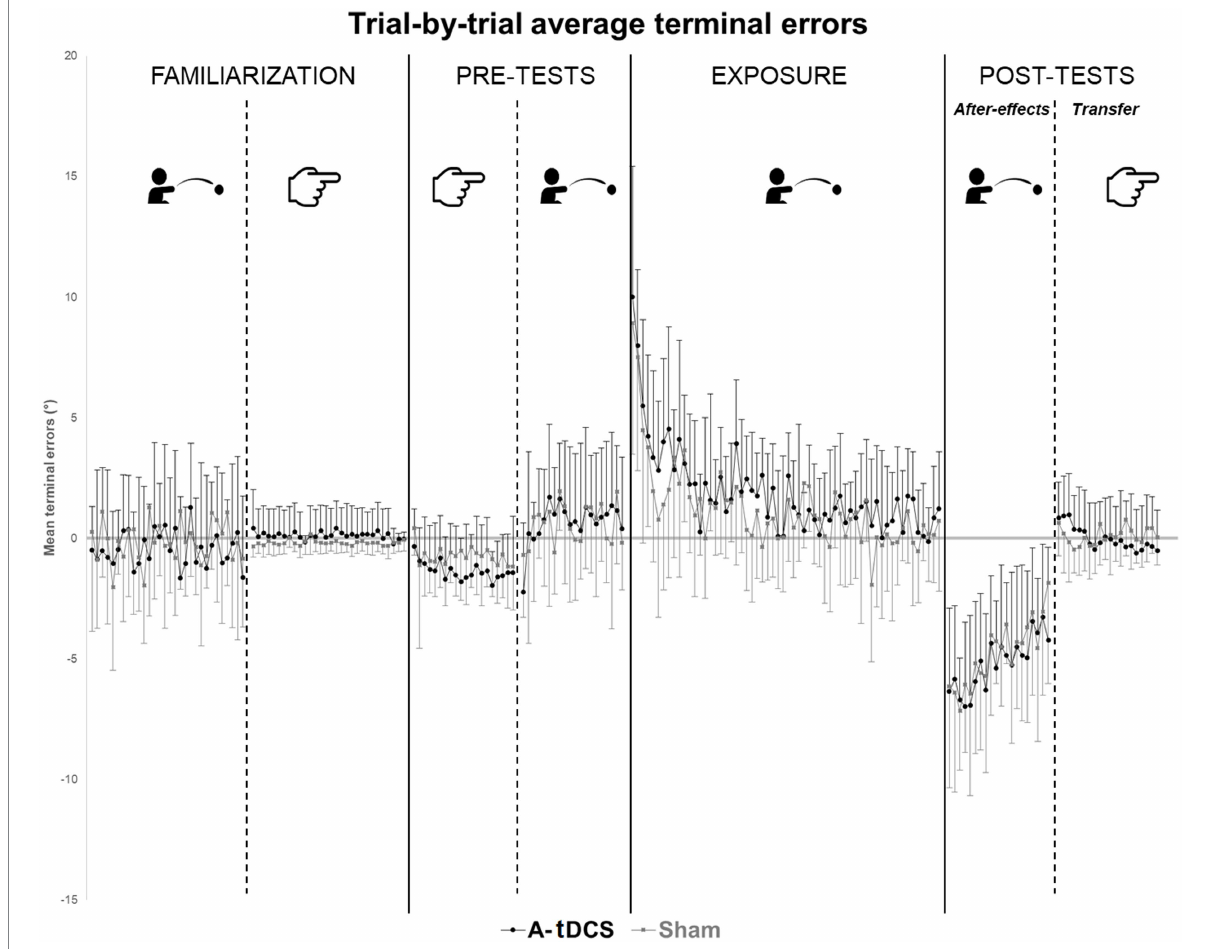
FIGURE 2 Trial-by-trial average terminal errors. Trial-by-trial average group terminal errors are represented with standard deviations for each group (A-tDCS group in black, Sham group in grey) and for each step of the